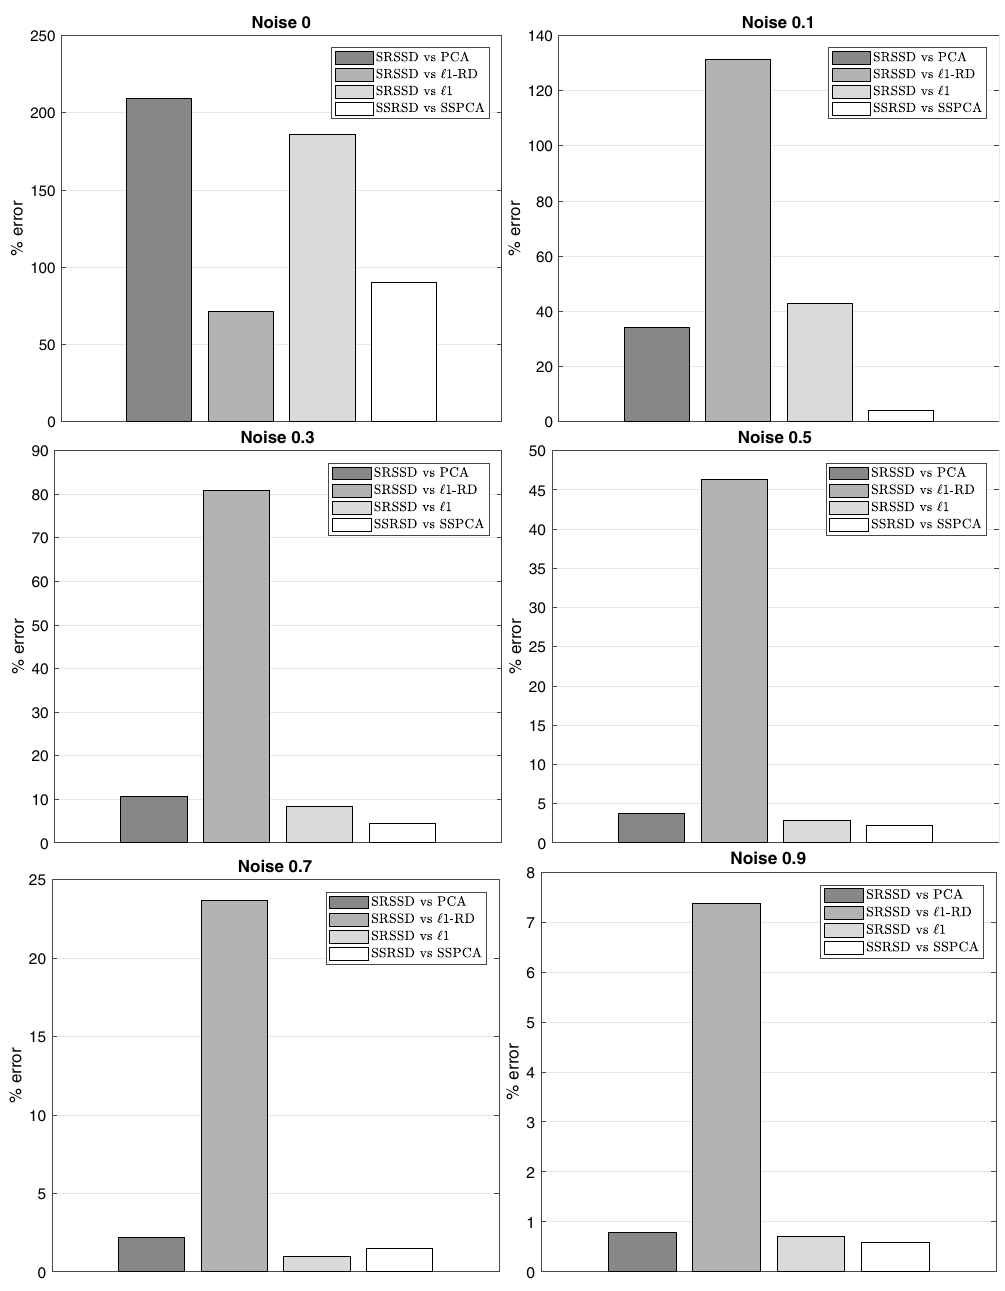
Figure 8. The percent error for PCA, ℓ 1 -RD, ℓ 1 -regularization, and SSPCA compared to SRSSD, across six levels of noise (0%, 10%, 30%, 50%, 70%, 90%). It is possible to appreciate that SRSSD outperforms the other methods, across all noise